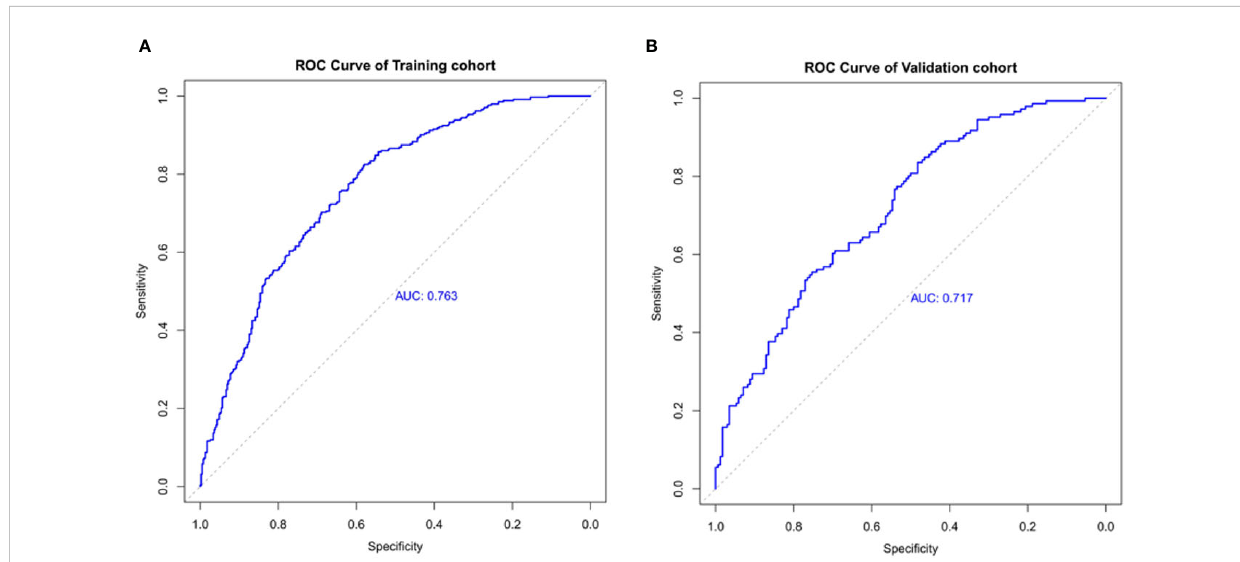
FIGURE 4 The nomogram model predicted the receiver operating characteristic curve of carotid atherosclerosis in patients with T2DM. (A) The area under the curve of the training cohort is 0.763. (B) The area under the curve of the validation cohort is 0.717.